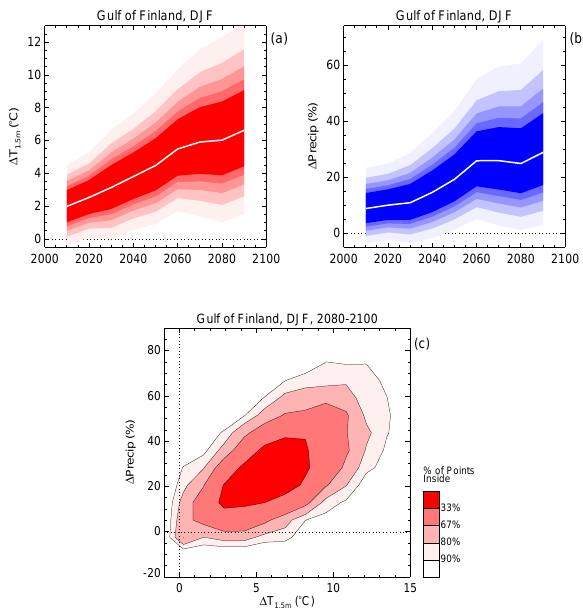
Fig. 8. Evolution of the median (white curve) and the 50, 60, 70, Figure 8. Evolution of the median (white curve) and the 50, 60, 70, 80 and 90% confidence 80 and 90% confidence ranges for: (a) 20 year mean winter sur- ranges for: (a) 20 year mean winter surface temperature change for the Gulf of Finland grid face temperature change for the Gulf of Finland grid point; (b) per- point; (b) percentage change in 20 year mean winter precipitation for the Gulf of Finland; (c) centage change in 20 year mean winter precipitation for the Gulf contours of the Winsorised sampled joint probability distribution function for surface of Finland; (c) contours of the Winsorised sampled joint probability temperature change and percentage precipitation change for the winter season for the Gulf of distribution function for surface temperature change and percentage Finland, for the period 2080-2099 relative to the 1961-1990 baseline period. precipitation change for the winter season for the Gulf of Finland, for the period 2080–2099 relative to the 1961–1990 baseline period. Fig. 9. Maps of the 10%, 50% (median) and 90% percentiles of the